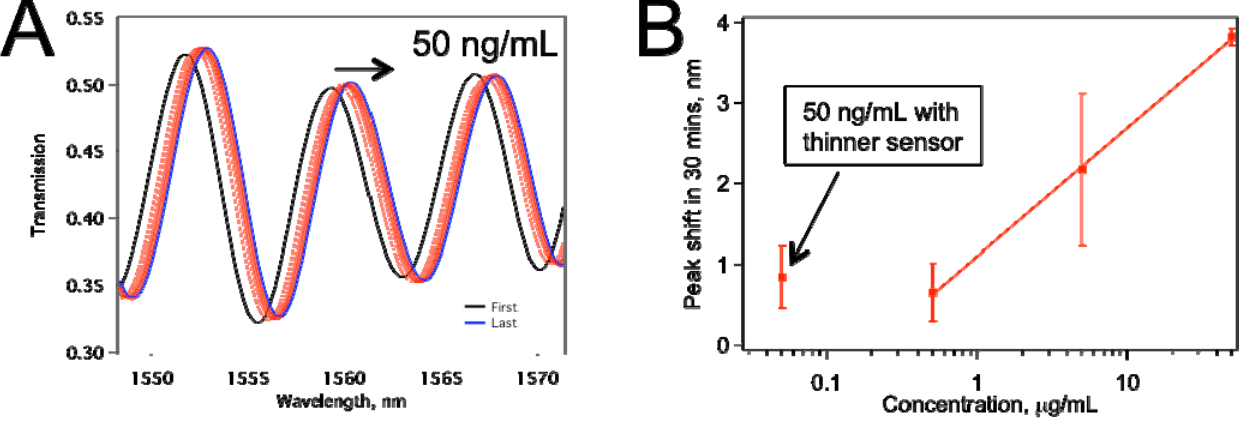
Figure 6. ( a ) Peak shift for a tapered fiber sensor that was HF treated. The anti-IgG concentration was 50 ng/mL; ( b ) The comparison of the thinner sensor performance with sensors ~10 µm thickness. Each data point represents at least two separate